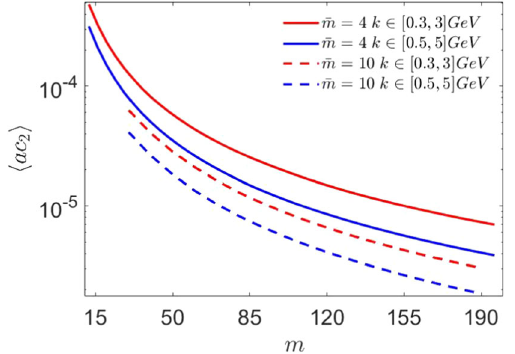
Fig. 13 The 3 point cumulant ac 3 averaged over region 0 . 5 < k i < 3 and 0 . 5 < k i < 5 (i=1,2,3)